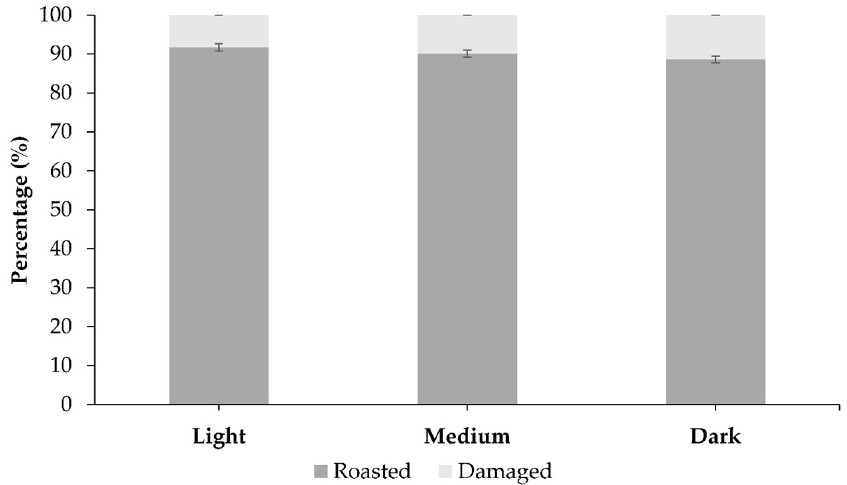
Figure 6. Roasting performance of CSR.